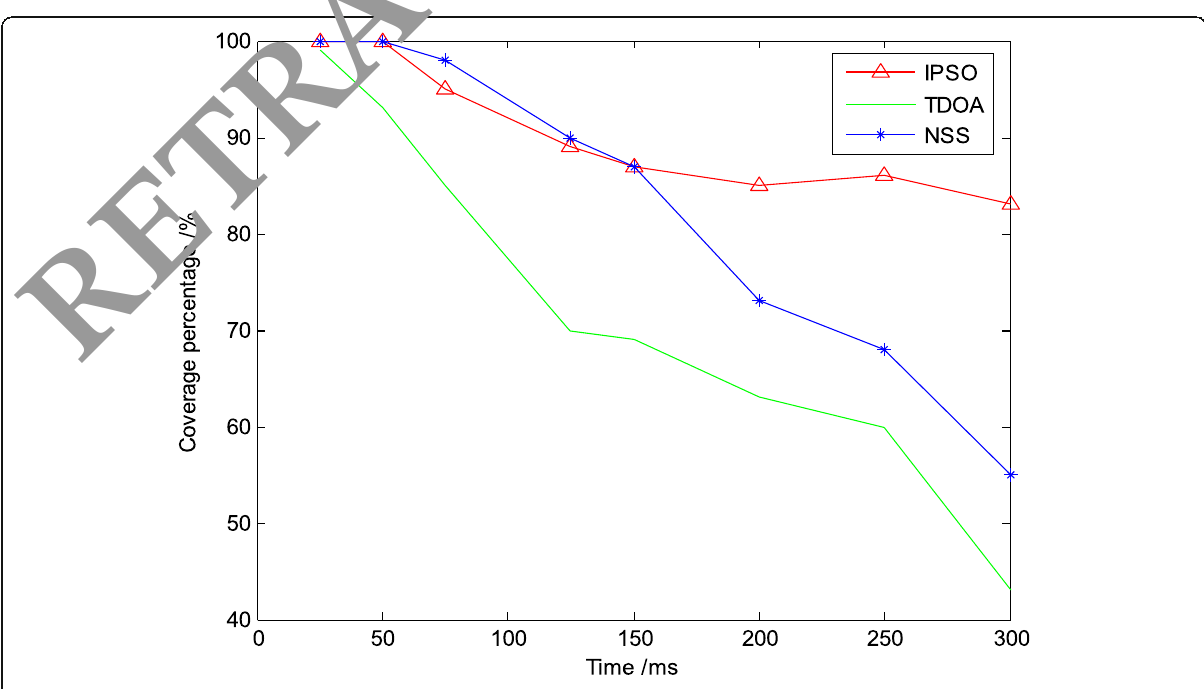
Fig. 4 Comparison of coverage percentage of three